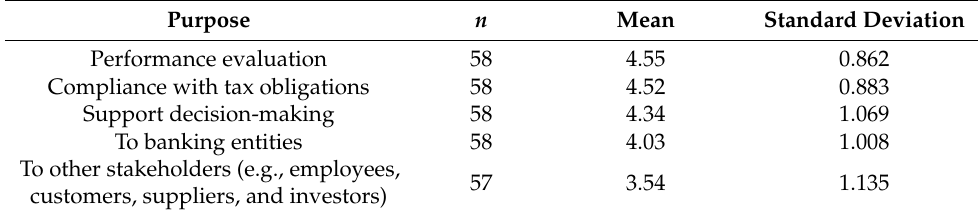
Table 2. AI importance by